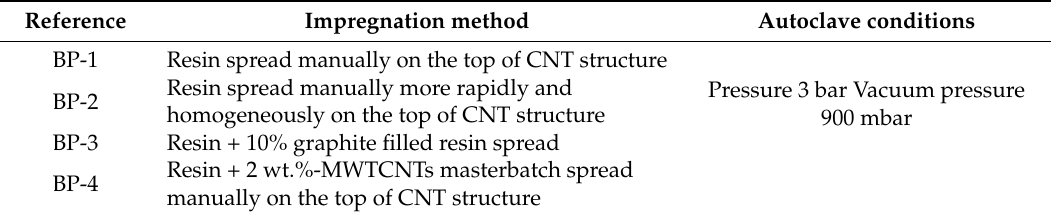
Table 10. Manufacturing runs and characteristics of buckypaper (BP).